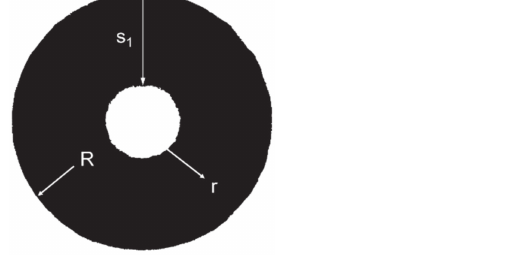
Figure 8. Method to calculate equivalent wall thickness of the